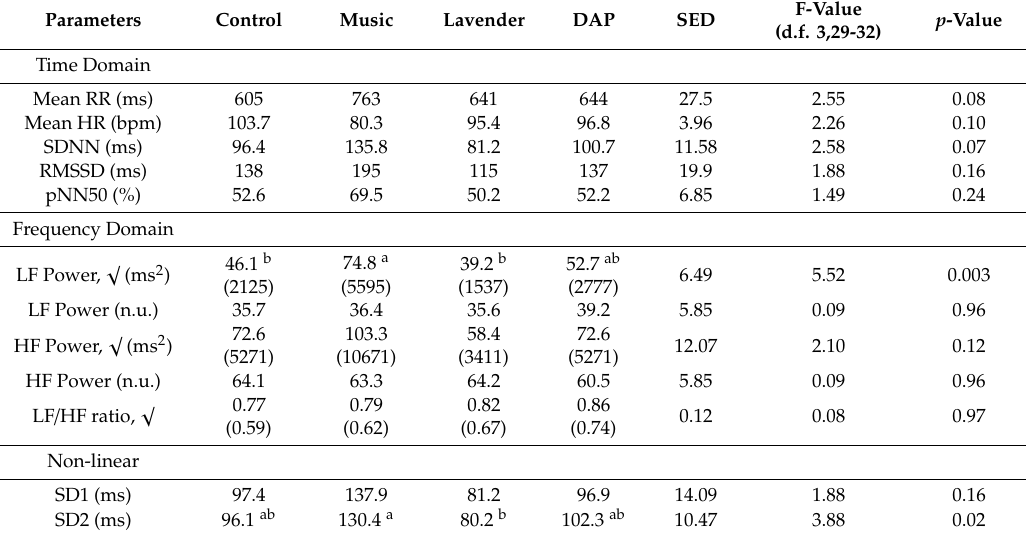
Table 2. HRV parameters of dogs ( n = 34) exposed to lavender, music, dog appeasing pheromone (DAP) or a control treatment in a shelter environment, during the treatment period. For square root ( transformed parameters, back transformed values are also reported in parentheses. Means that do